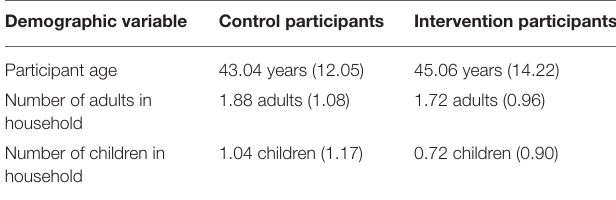
TABLE 1 | Descriptive statistics, including means (and standard deviations) on demographic